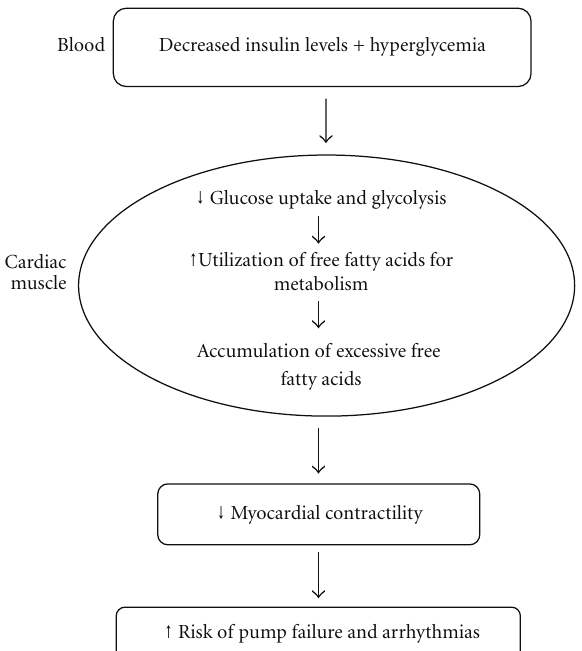
Figure 1: Hyperglycemia and its e ff ect on cardiac function.